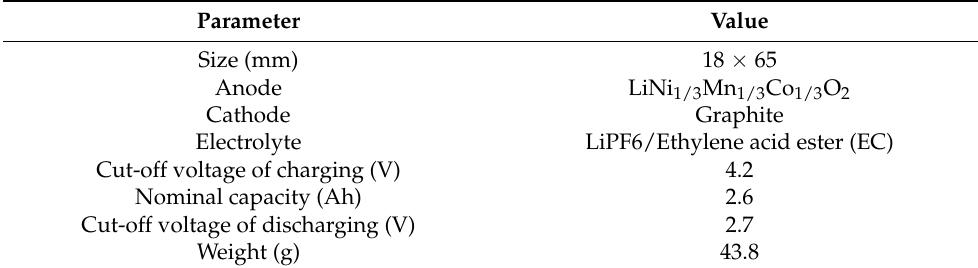
Figure 1. Design of BTMS: ( a ) Preparing process of CSG, ( b ) Design of the CSG – LC module, ( c ) Configuration of detected batteries. Table 1. The parameters of the prismatic LIBs in the